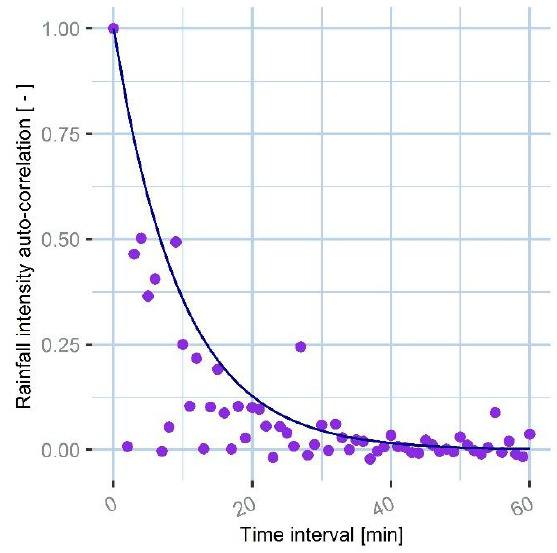
Figure 5. Rainfall intensity autocorrelation function.